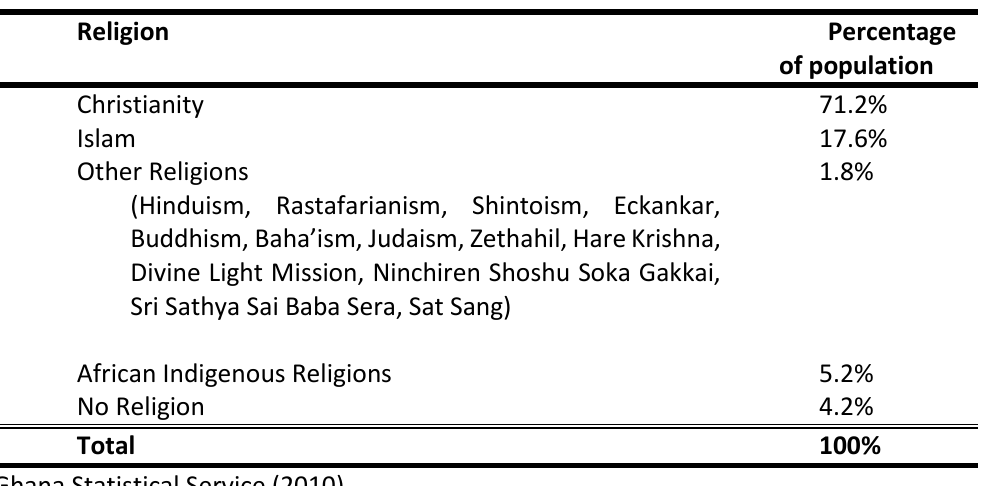
Ghana Statistical Service